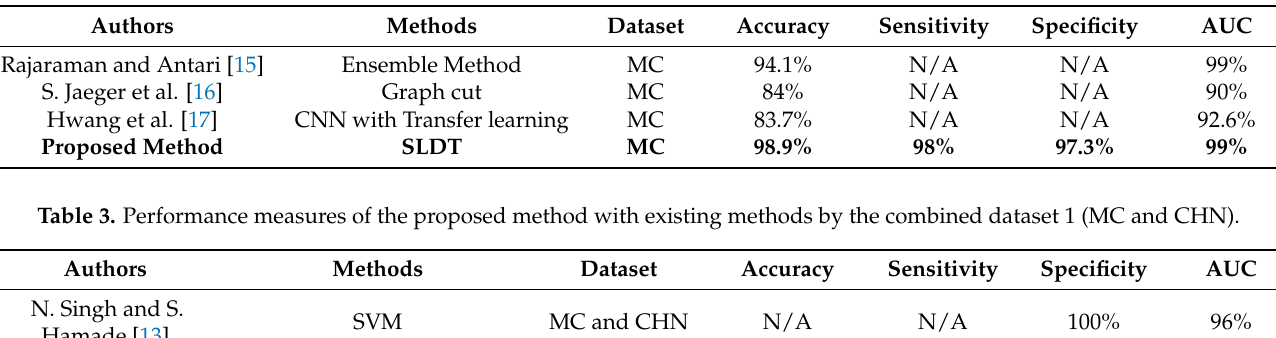
Table 2. Performance measures of the proposed method with the existing methods by the MC dataset.